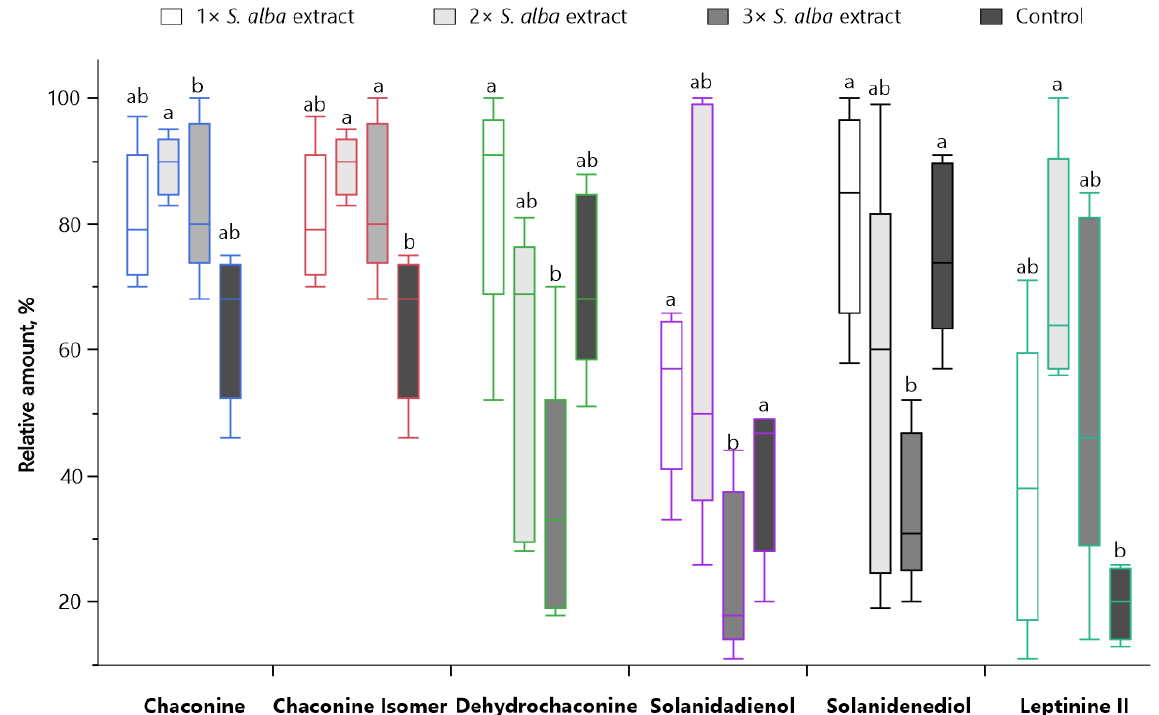
Figure 2. Amounts of six glycoalkaloids that were sensitive to S. alba extract treatment. Values ± standard errors are the average of five replicates. Values within the same series followed by a common letter are not significantly different ( p ≤ 0.05).